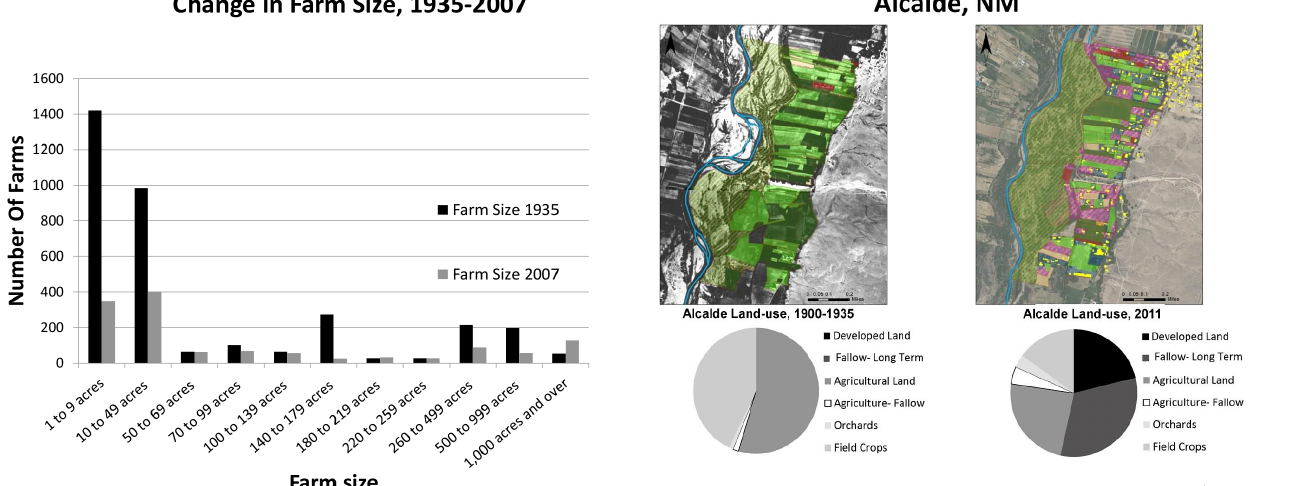
Figure 7. Community level changes in land use for Alcalde (Earth Data Analysis Center, 2010; Rio Arriba County Assessor’s Office, 2013).